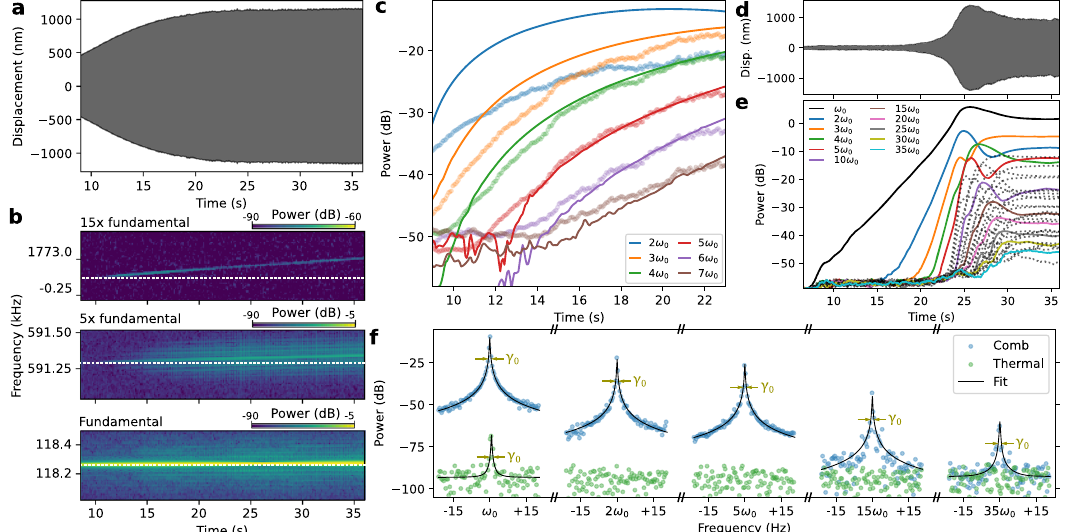
(differentchip)than a ,showinggrowth from closetothethermalregimeto steady state. e Overtone amplitudes extracted from the spectrum of measurement of d ,showingall35overtoneswithinthe detectionbandwidth(black,dottedlinesare overtoneswithnumbersbetweenthelabeledones). f Spectrumshowingmeasured fundamental mode and some selected overtones in the comb regime (blue) and thermal (green), along with Lorentzian fi t with center frequencies n ω 0 ( n integer) and identical linewidths γ 0 .